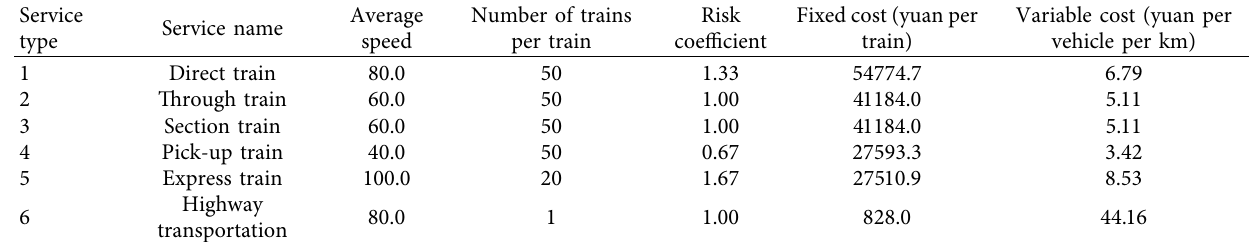
Table 3: Parameters of transport services.